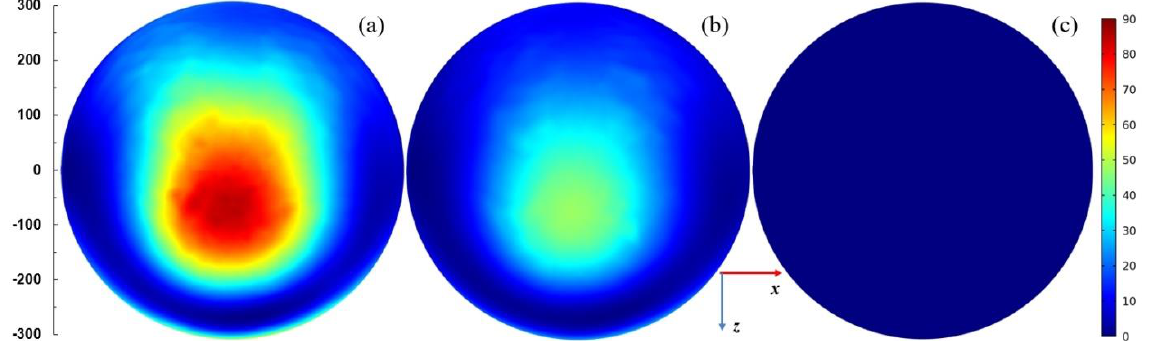
Figure 15. Spatial distributions of the log 10 of | E |/(1 Vm −1 ) in x - y plane passing through the center of the plasma for P ent = 100 W and closed configuration. ( a ) L = 15 mm, ( b ) L = 20 mm, and ( c ) L = 30 mm. The scale is the same as in Figure 7. The scale on the left shows dimensions in mm.